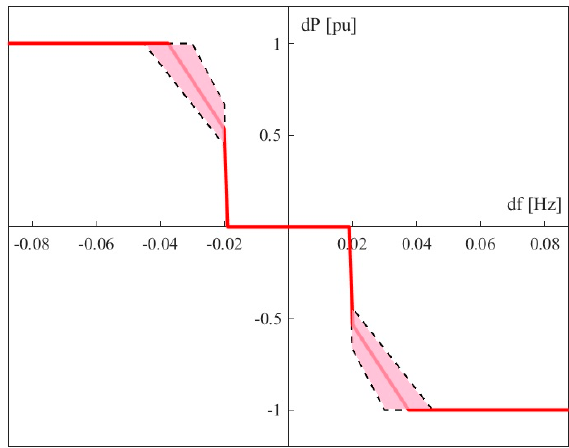
Figure 5. The variable droop adopted to simulate over/under-regulation schemes. Dead-band is equal to the one adopted in the other cases. The pink area, instead, shows the possible dP that can be delivered at each dF. Full activation dF varies between ±30 and ±45 MHz.